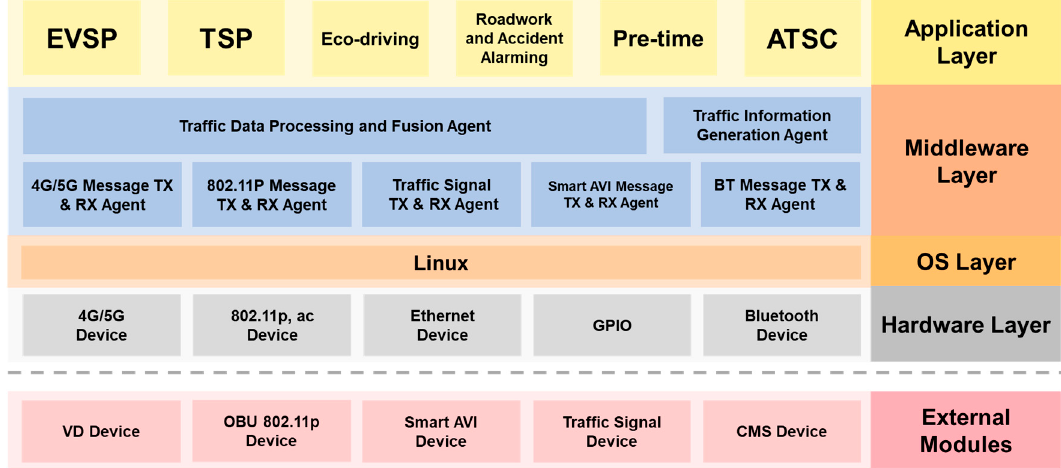
Figure 2. Software architecture of the RSU controller.